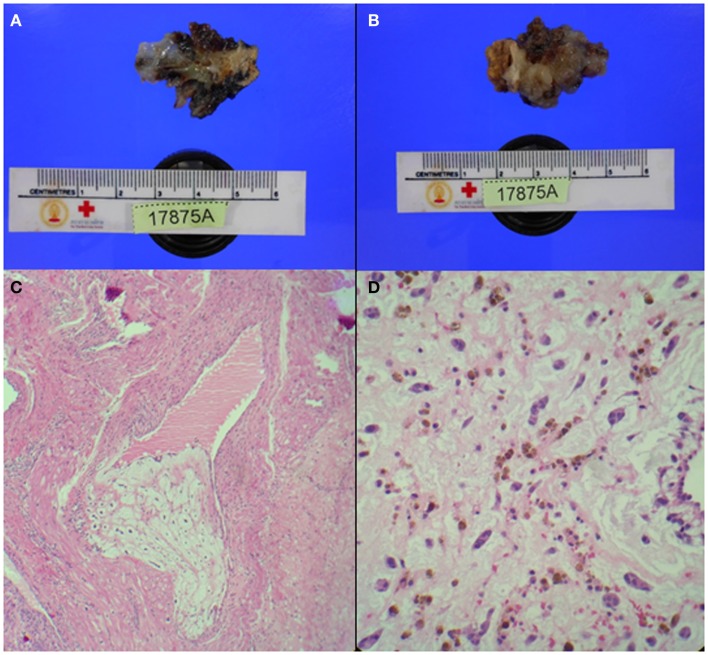
Pathology findings. (A,B) Gelatinous tissue (4 cm × 2.5 cm × 0.8 cm) attached to part of tumor stalk (1.5 cm × 1 cm × 0.5 cm). (C) Extension of tumor tissue into trabecule and venous channel. (D) Tumor cells: spindle or stellate shape, eosinophilic cytoplasm, and bland-looking nuclei. Tumor cells were located in myxoid stroma and surrounded by numerous red blood cells.